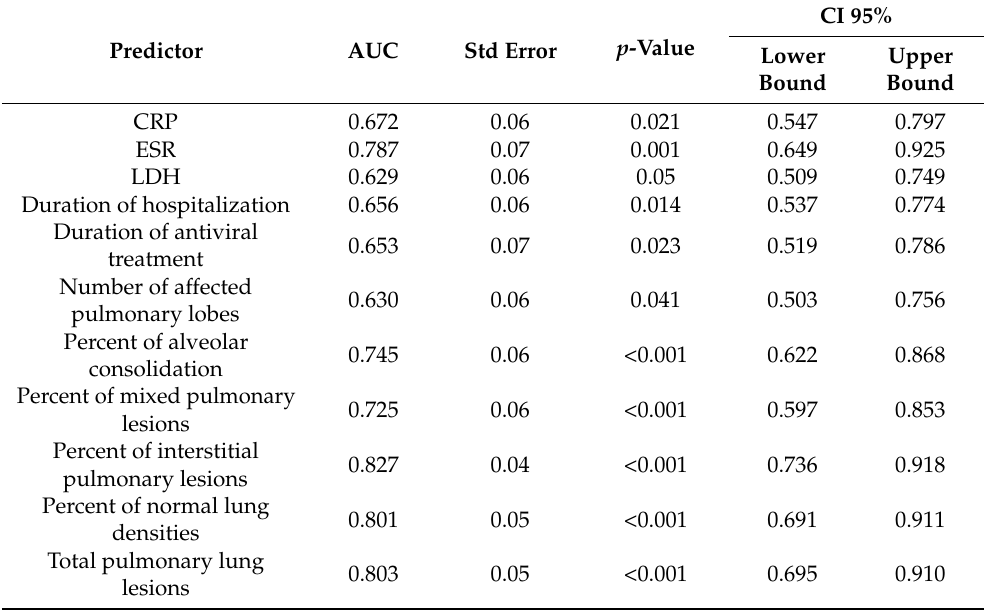
Table 4. ROC curve analysis for the variables with individual prediction of lung fibrosis.